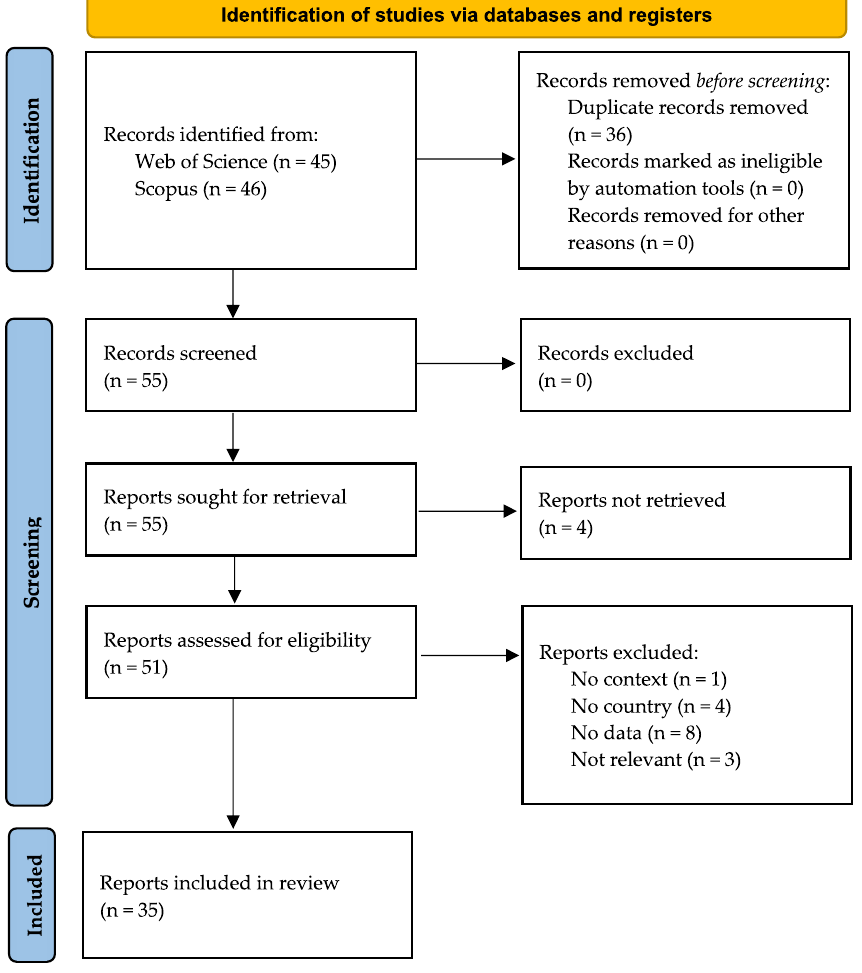
Figure 1. PRISMA flow